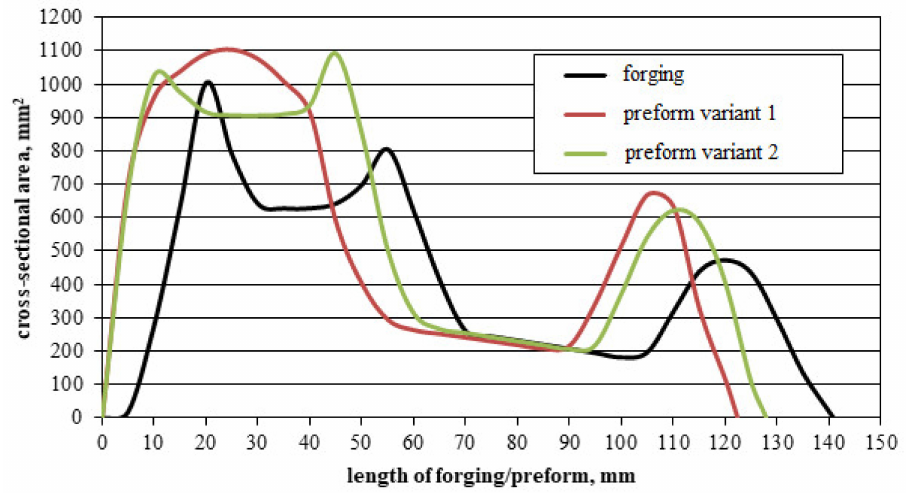
Figure 4. Diagram of cross-sections of forging and preforms.